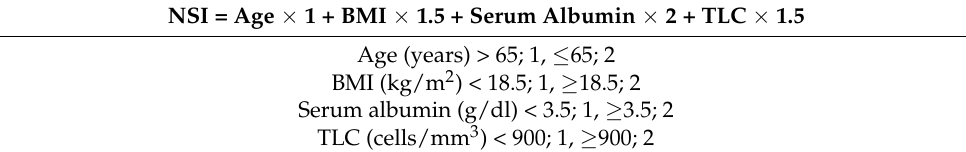
Table A1. Nutrition screening index in SNUBH.